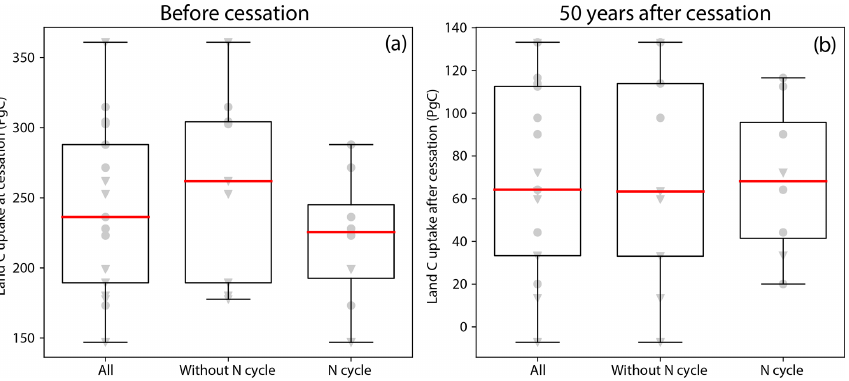
Figure 8. Terrestrial carbon uptake for models with and without a nitrogen cycle, before emissions cease and after emissions cease. A total of 8 models have a representation of nutrient limitations while 10 do not. Circles indicate data points for ESMs, and triangles indicate data points for